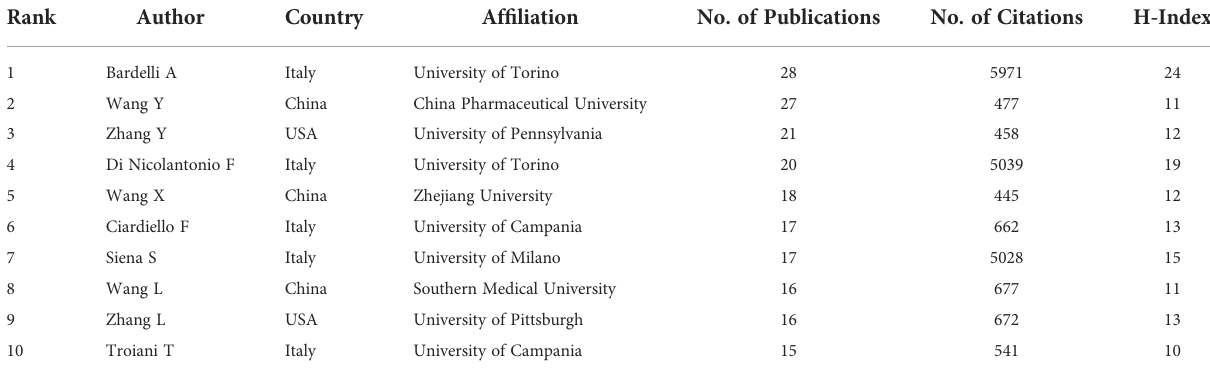
TABLE 3 Top 10 authors with most publications in research scope of drug resistance in colorectal